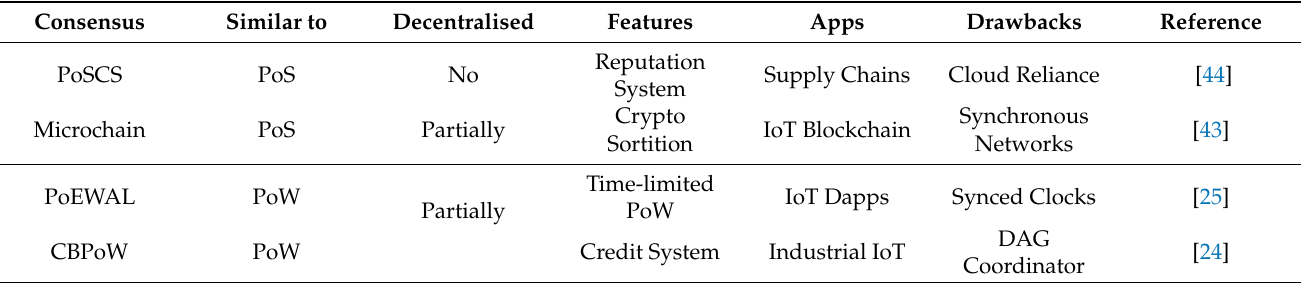
Table 2. Overview of the IoT specific consensus mechanisms mentioned in Sections 4 and 5.